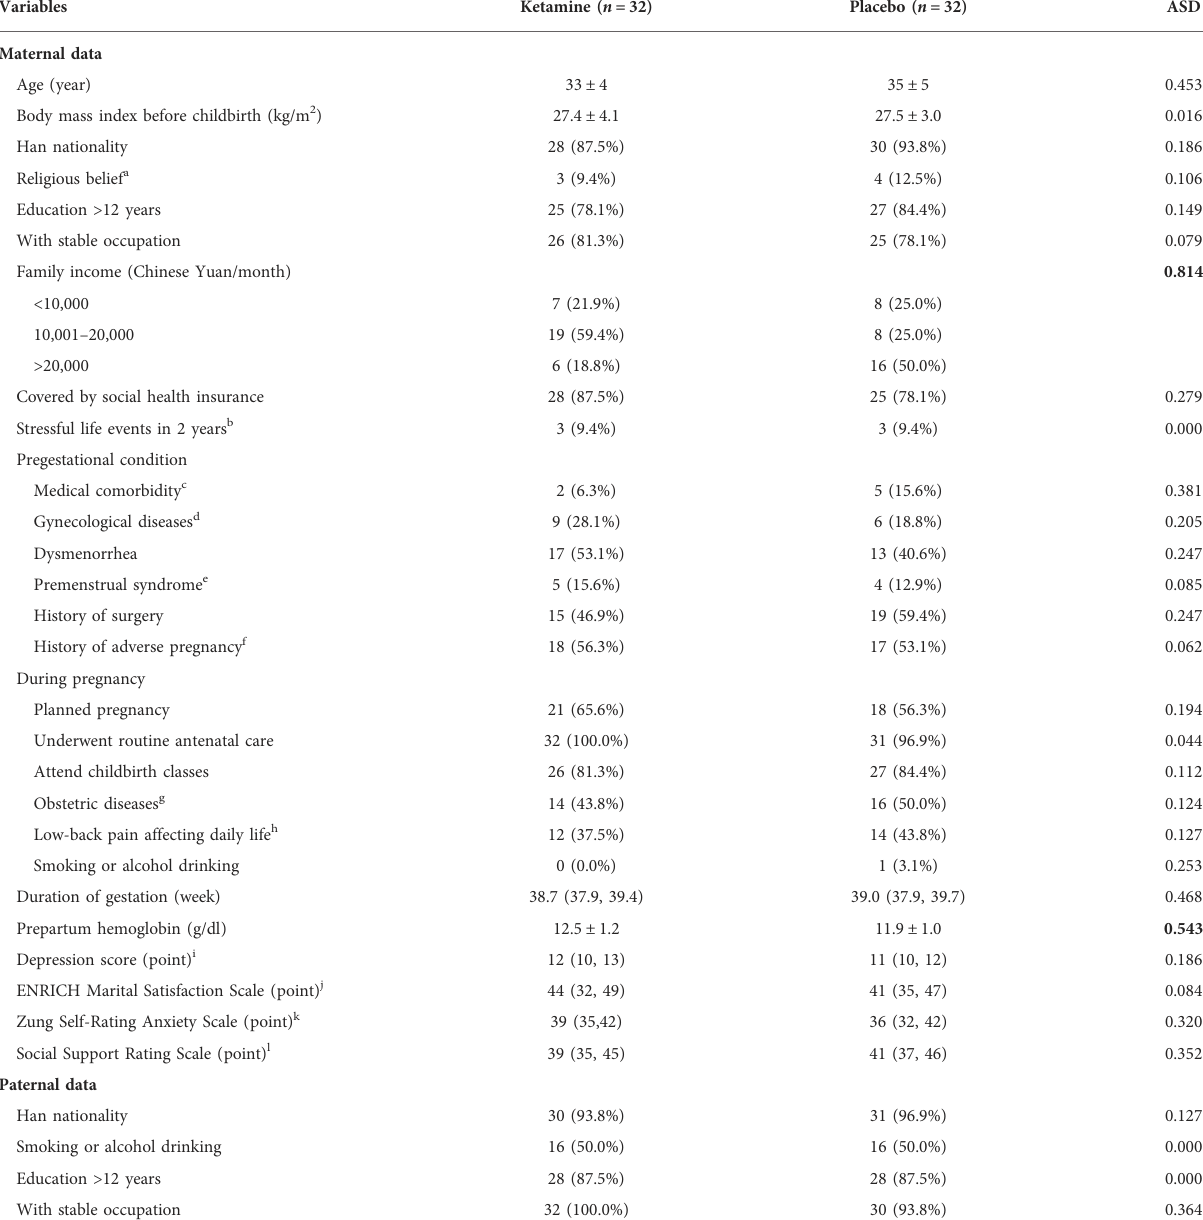
TABLE 1 Baseline